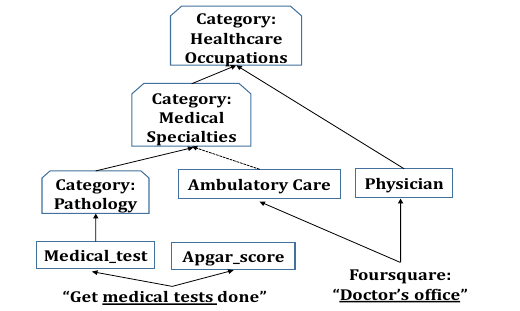
Figure 5: Graphical illustration of the lch calculation for the phrases “Get medical tests done” and “Doctor’s